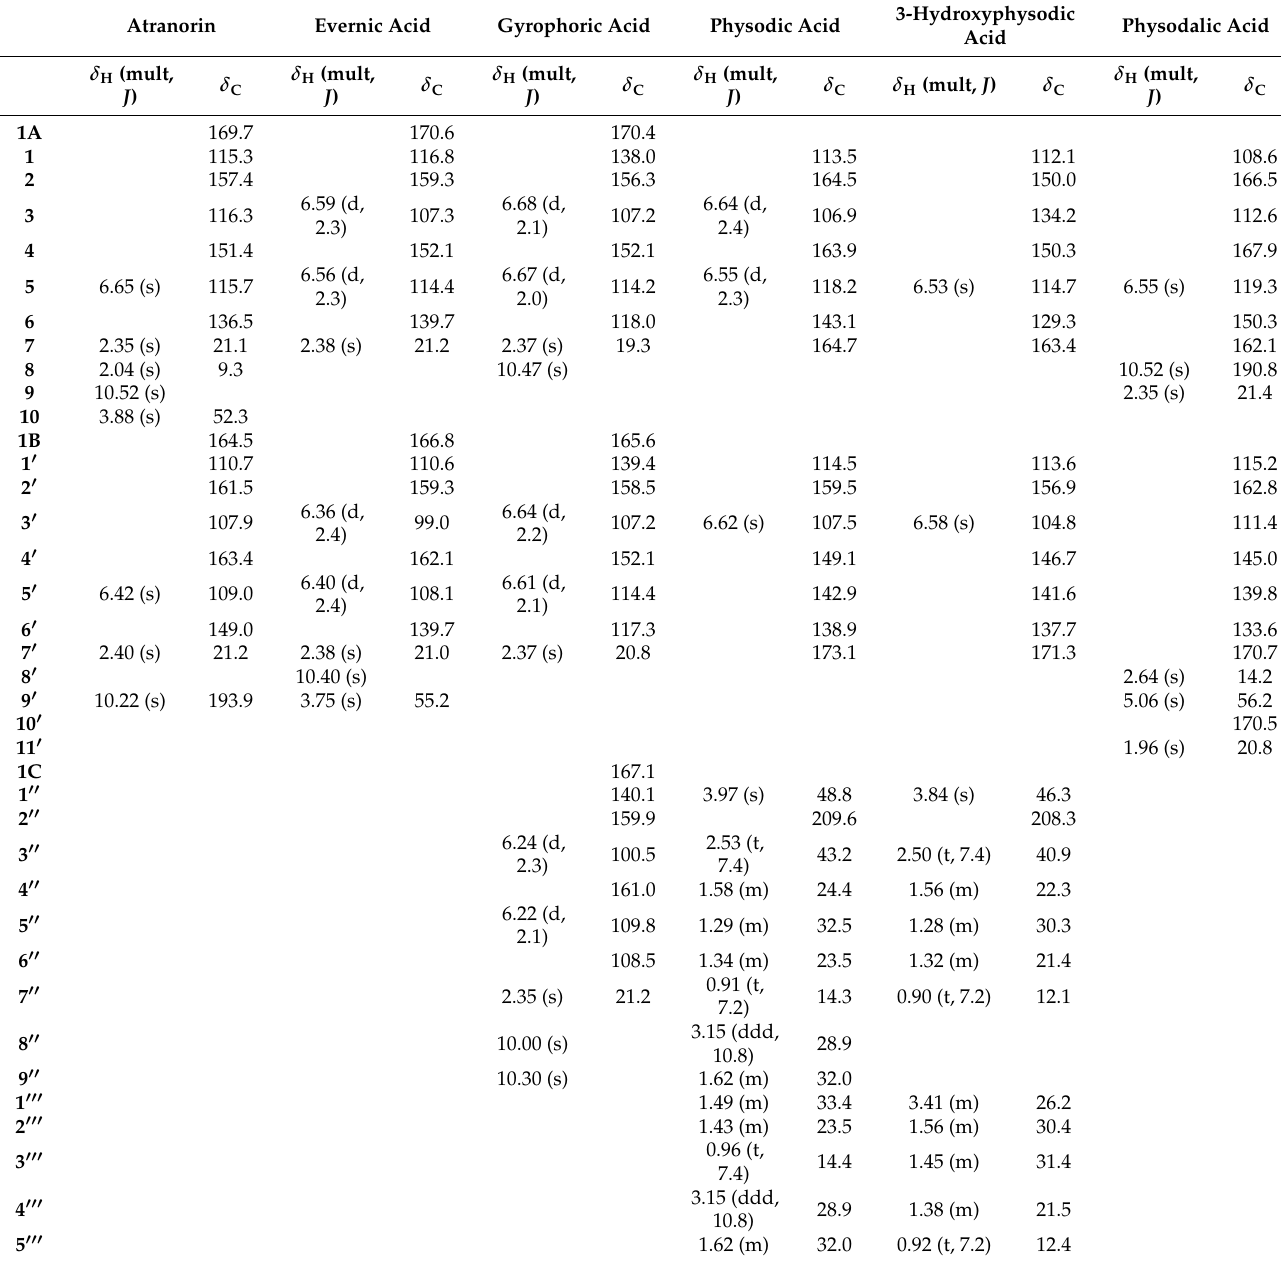
Table 1. 1 H (600 MHz) and 13 C (150 MHz) NMR data of atranorin, evernic, gyrophoric acid,